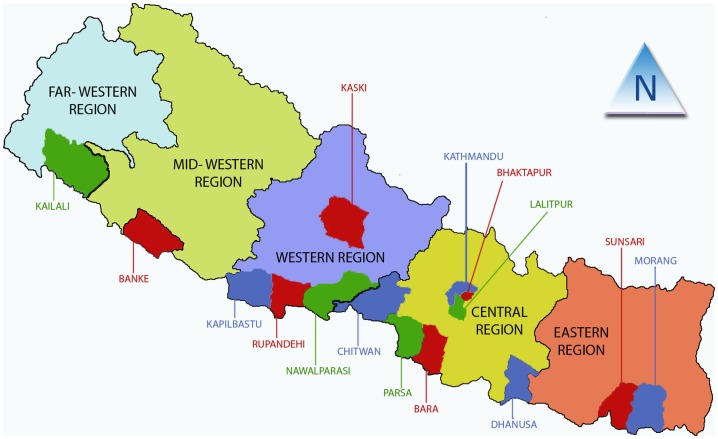
Sampled districts.